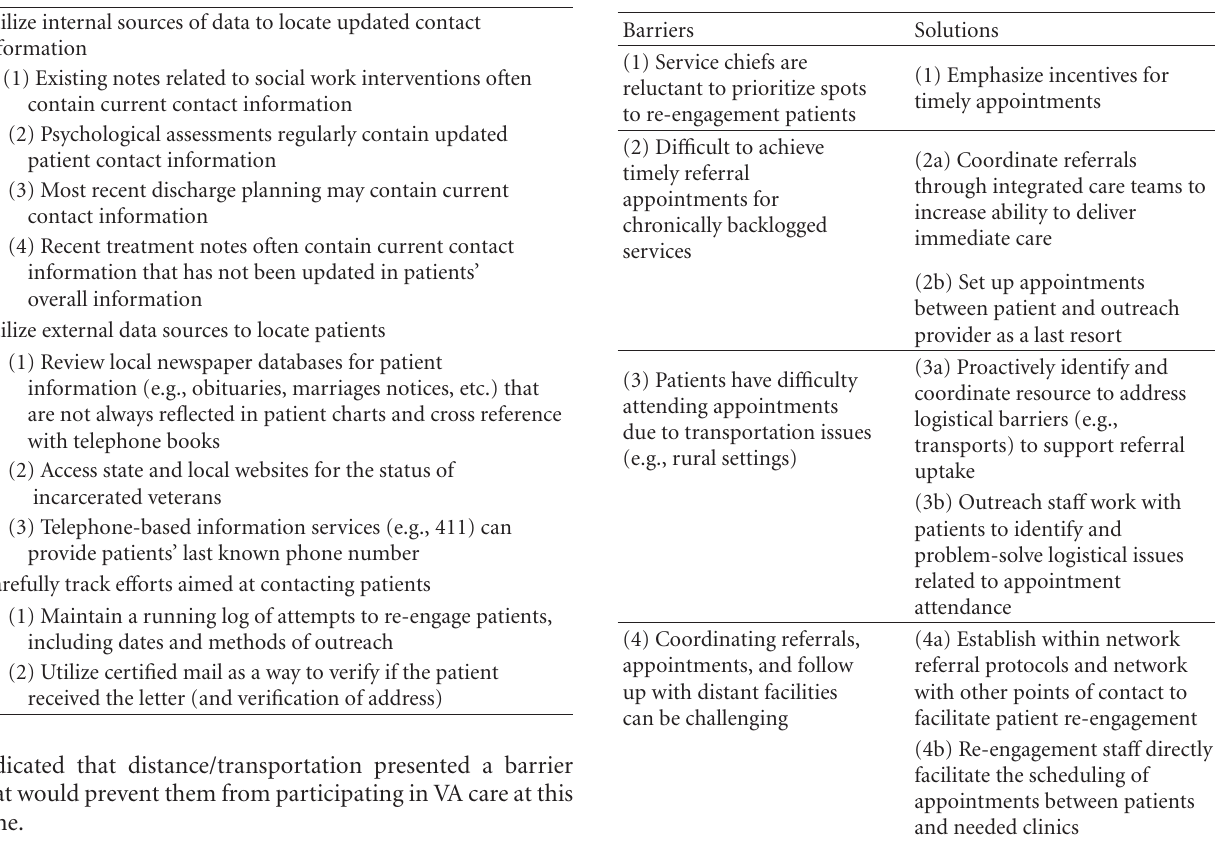
Table 4: Recommended strategies to contact Veterans or verify Veteran status.